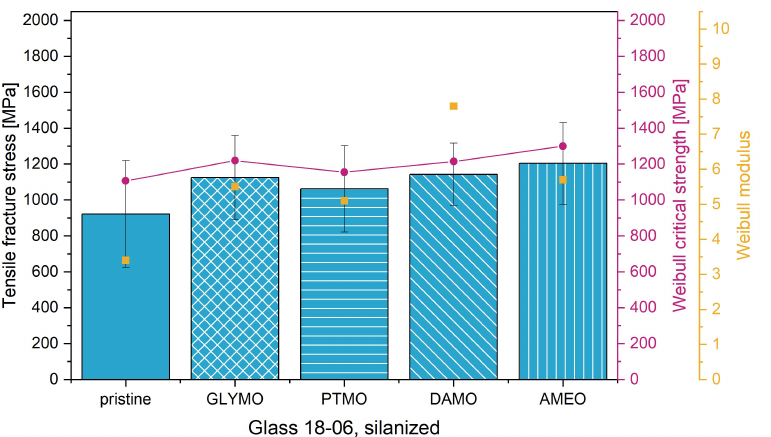
Figure 13. Effect of silanes on the tensile strength of glass fibres from glass